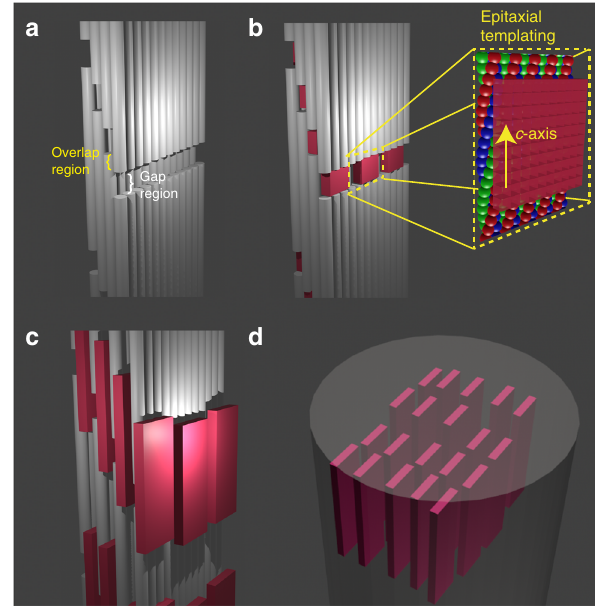
Fig. 1 Schematic representation of the deck-of-cards model of mineralized collagen. The model considers the collagen fi bril to comprise staggered molecular layers and the gap regions to contain rectangular shaped channels ( a ) 1,11,13 . In that model the HAp crystals nucleate in the gap regions ( b ), where they are epitaxially templated by charged functional groups (inset in b ) 9,18 . They subsequently develop into platelets that are embedded between the collagen layers as shown in c . A 3D array of oriented parallel platelets eventually forms, as shown in d